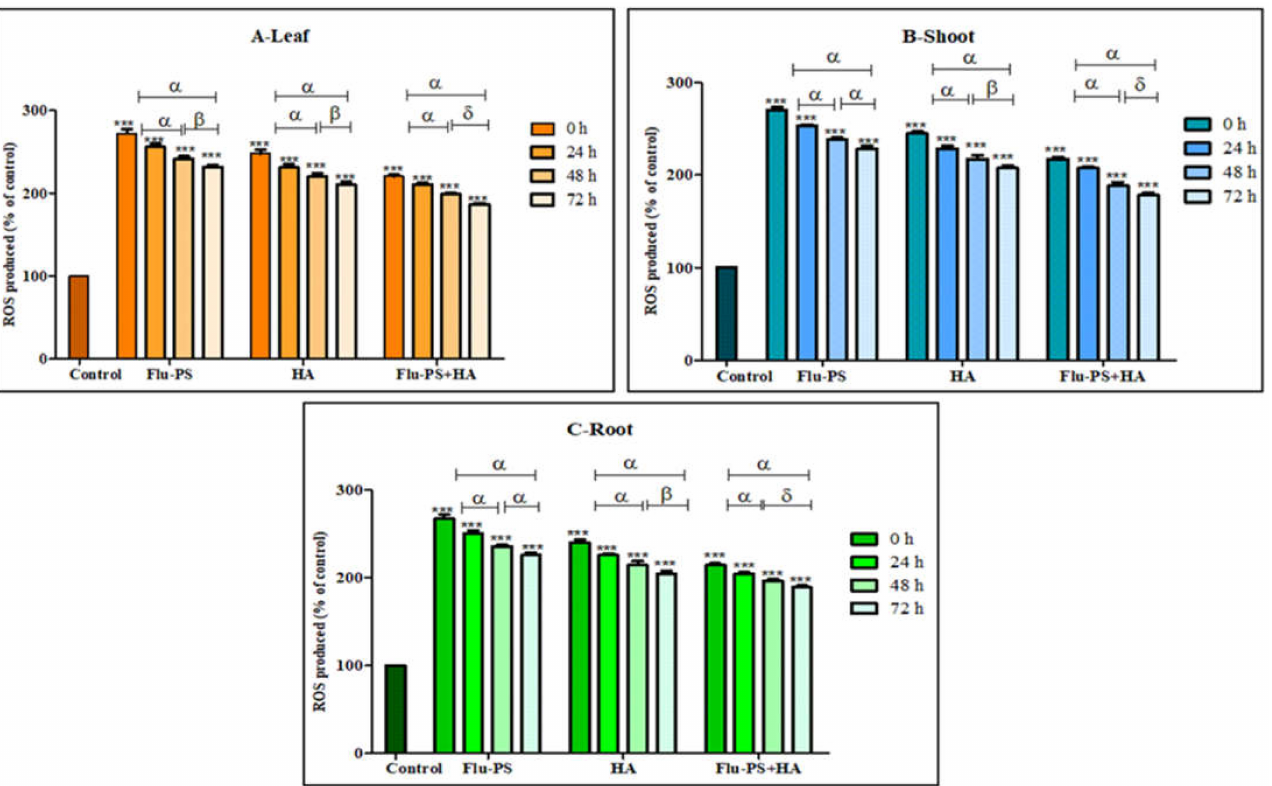
Figure 11. Intracellular reactive oxygen species (ROS) values of Flu − PS-, HA- and Flu − PS+HA- treated (( A ). Leaf, ( B ). Shoot, ( C ). Root) Solanum lycopersicum samples. Note: ‘ *** ’ indicates the per- centage difference with respect to the control; ‘ α , β , δ ’ indicates a significant difference ( α = p < 0.001, β = p > 0.001, δ = p >